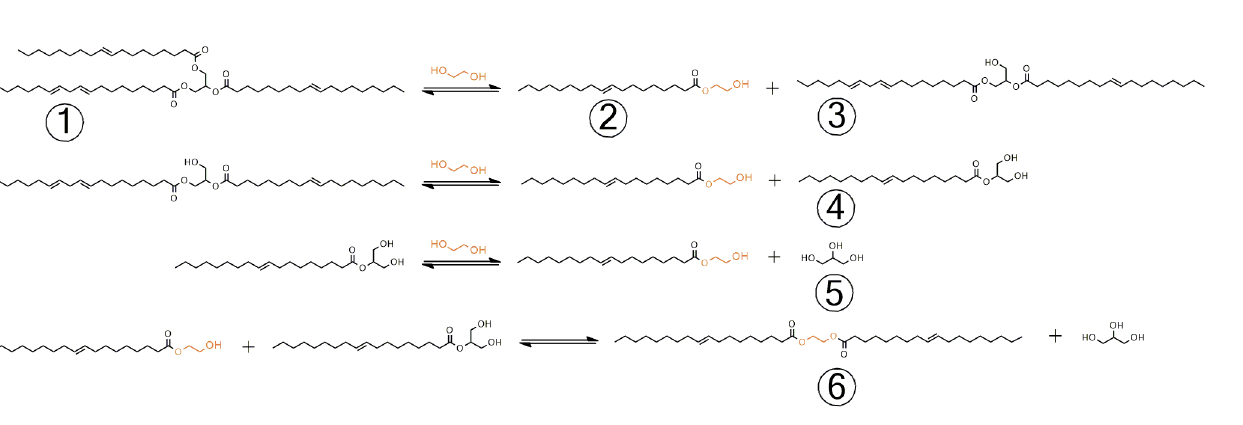
Figure 2. Transesterification course and the reaction products: 1 — triglyceride, 2 — ethylene glycol monoester, 3 — diglyceride, 4 — monoglyceride, 5 — glycerol and 6 — ethylene glycol diester.